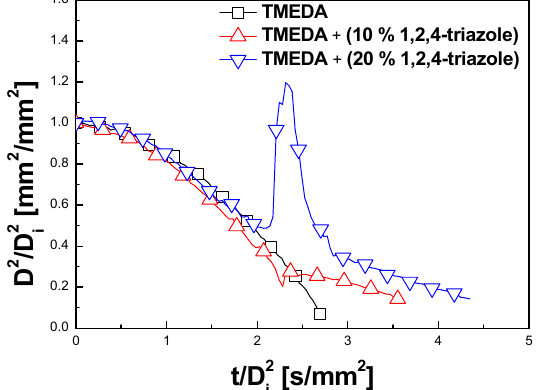
Figure 11. Sequential images of the evaporating TMEDA + (20% 1,2,4-triazole) droplet at 400 °C.